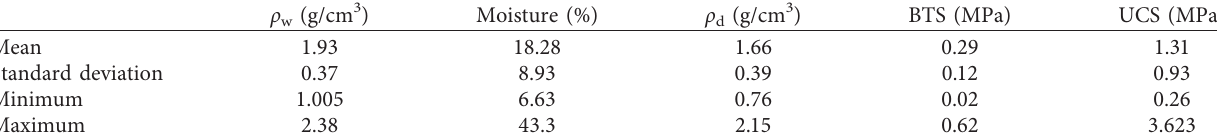
Table 3: Statistical distribution of UCS dataset.